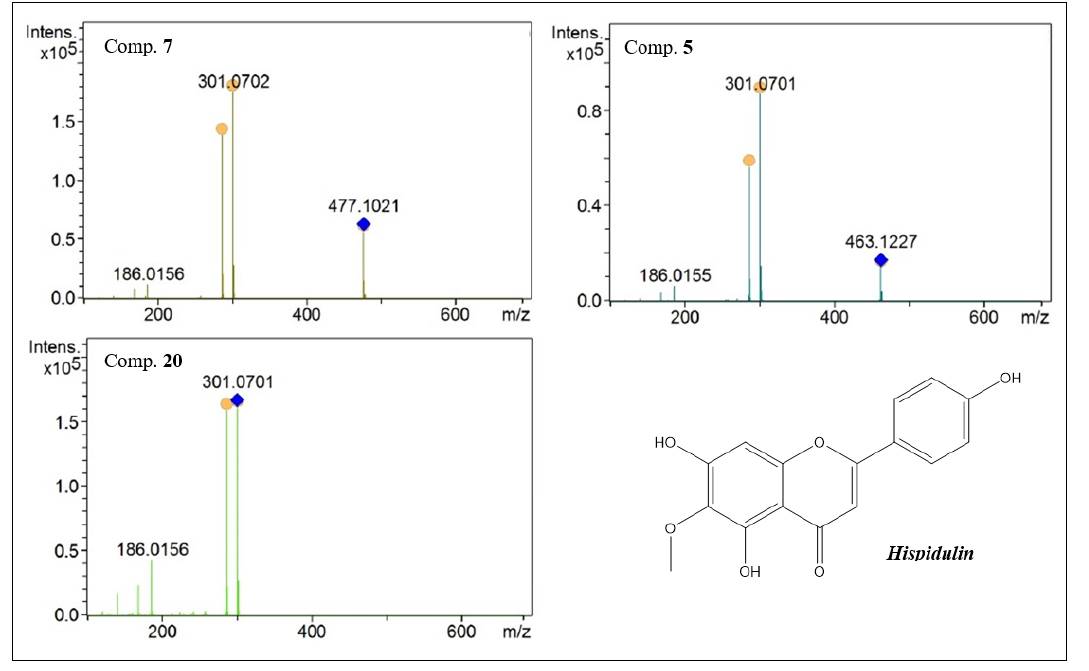
Figure 8. MS 2 spectra of flavones with hispidulin-like aglycones present in the ethanolic extract of F. chica leaves.